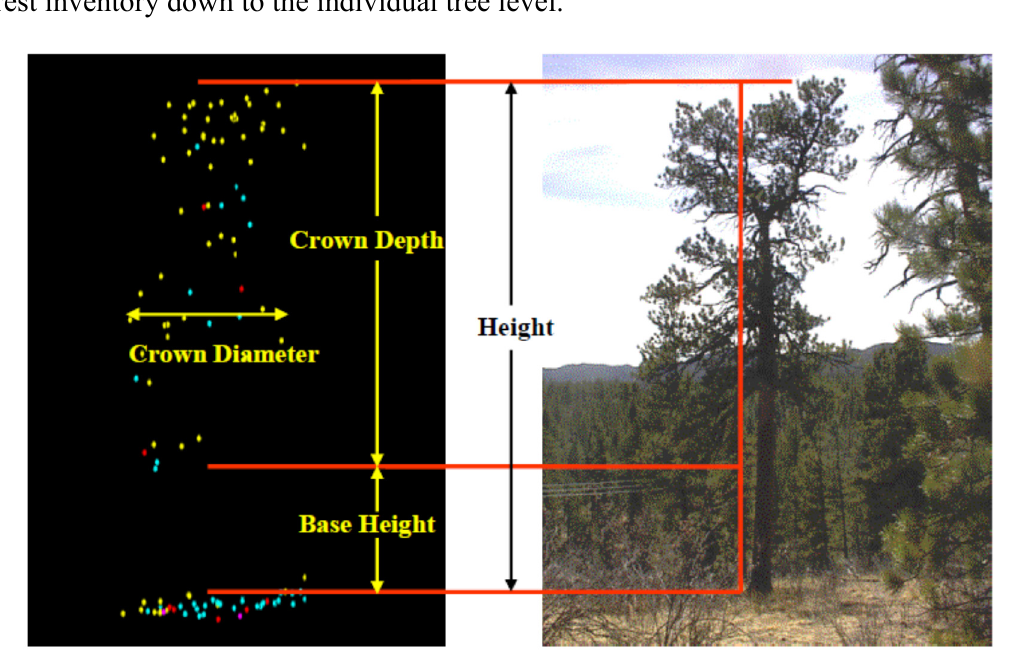
Figure 1. Illustration of tree metrics estimation using raw LiDAR